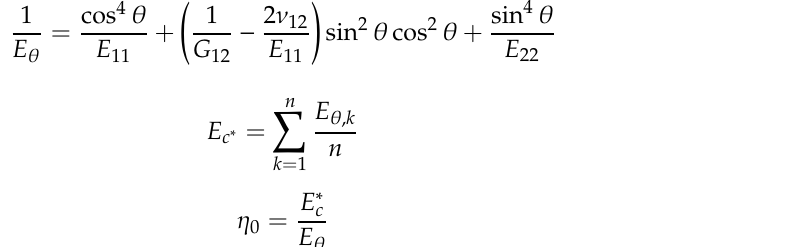
Figure 18. Fibre orientation analysis showing ( a ) ellipse fitting performed on PLA cross section and ( b ) resulting in-plane fibre distribution.